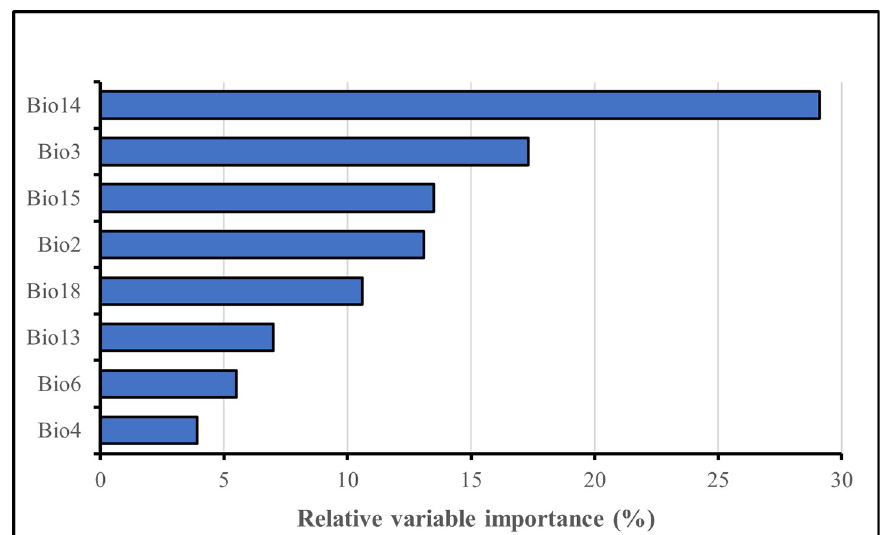
Fig 4. The importance of a variable in explaining macadamia suitability in Malawi. Data is obtained from the averages of the 18 species distribution model algorithms.